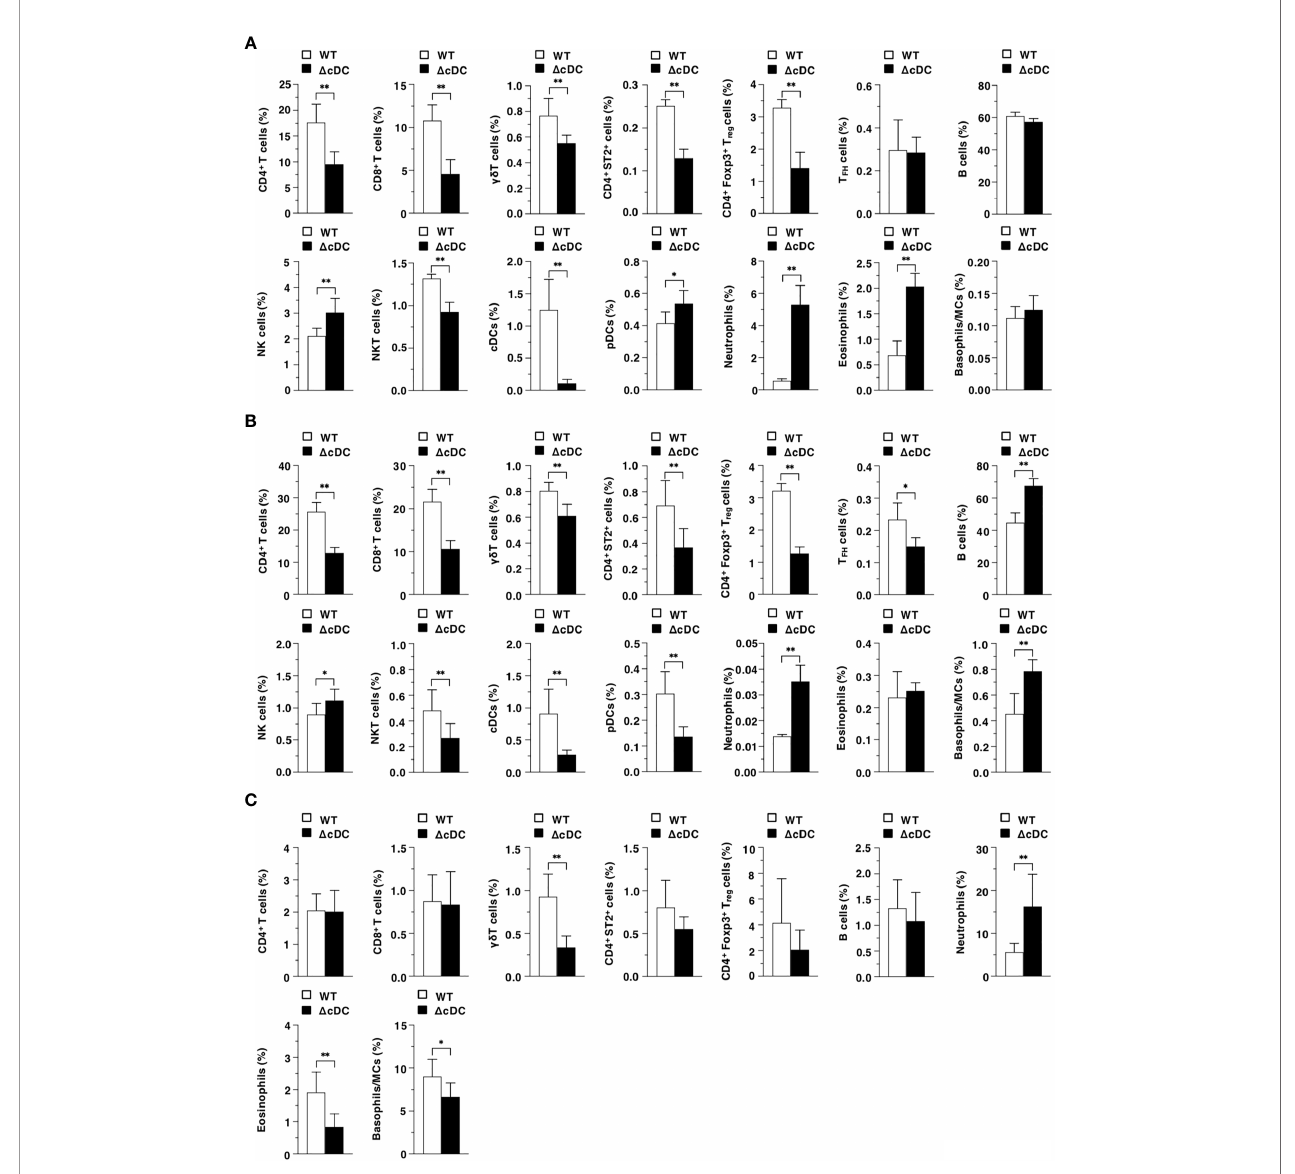
FIGURE 2 | Constitutive loss of cDCs accelerates the AD-associated abnormal immune cell composition.The frequency of leukocytes in Spl (A) , EDLNs (B) , ear skin (C) obtained from WTmice and D CD11c hi cDC mice (n= 10 per group)at 16 daysafter topical application with MC903. Dataare obtained from ten individual samples in a singleexperiment. * P < .05, ** P < .01 comparedwith WTmice bytwo-sidedpairedstudent t -test. Alldata are representative ofat least3 independent